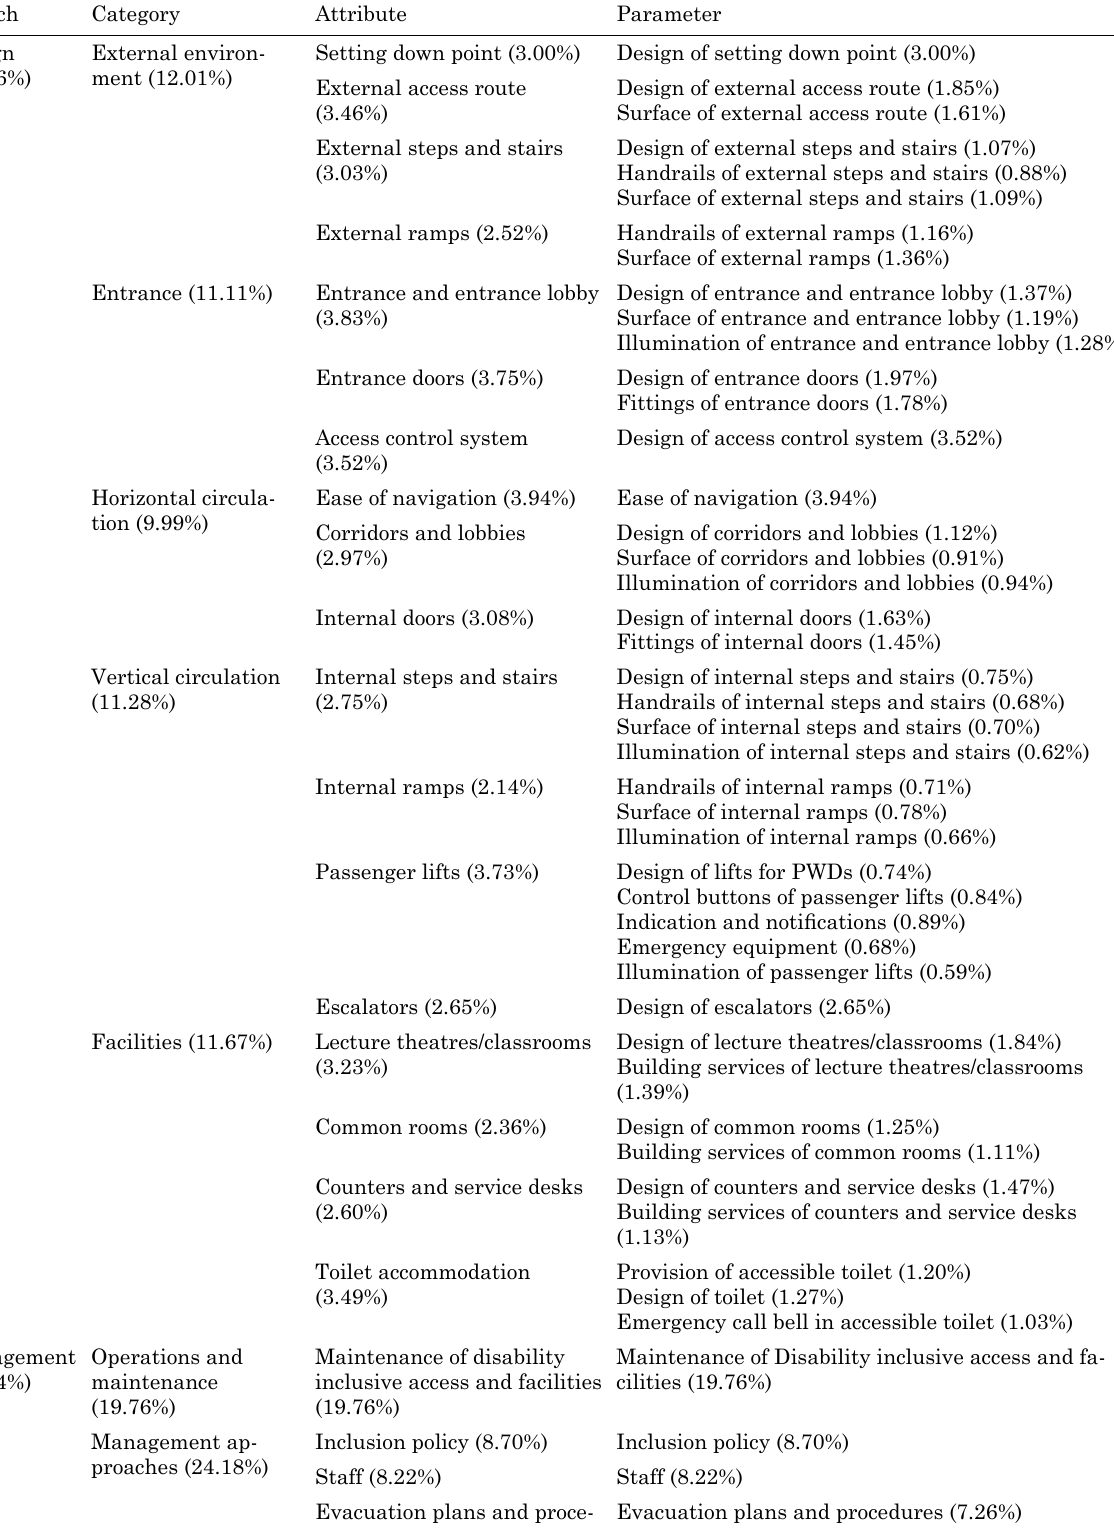
Table 2. Inclusion categories, attributes and parameters for the VIIS and weightings Branch Category Design